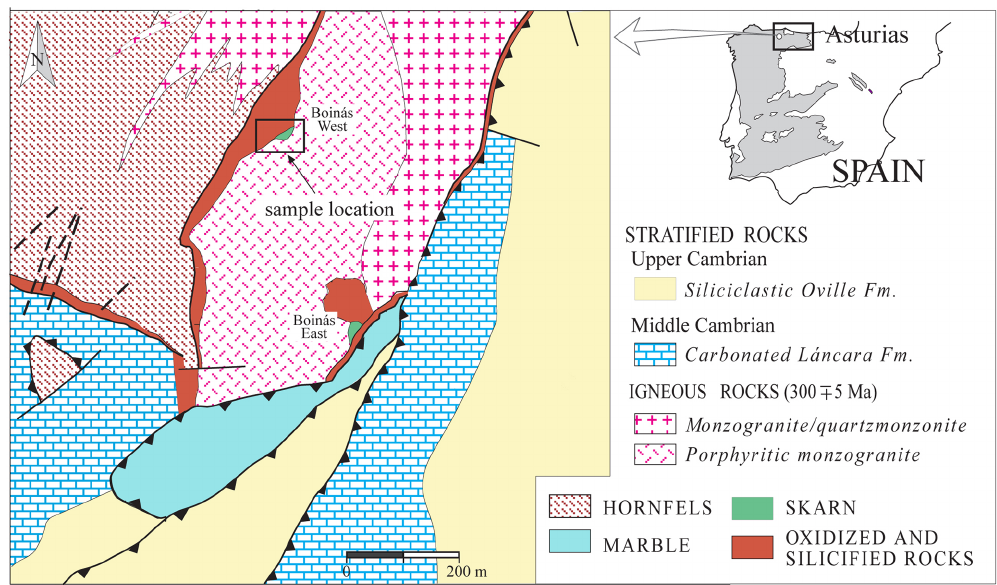
Figure 1. Schematic geology of El Valle-Boinás Cu–Au deposits where silesiaite was found (modified from Cepedal et al., 2003).